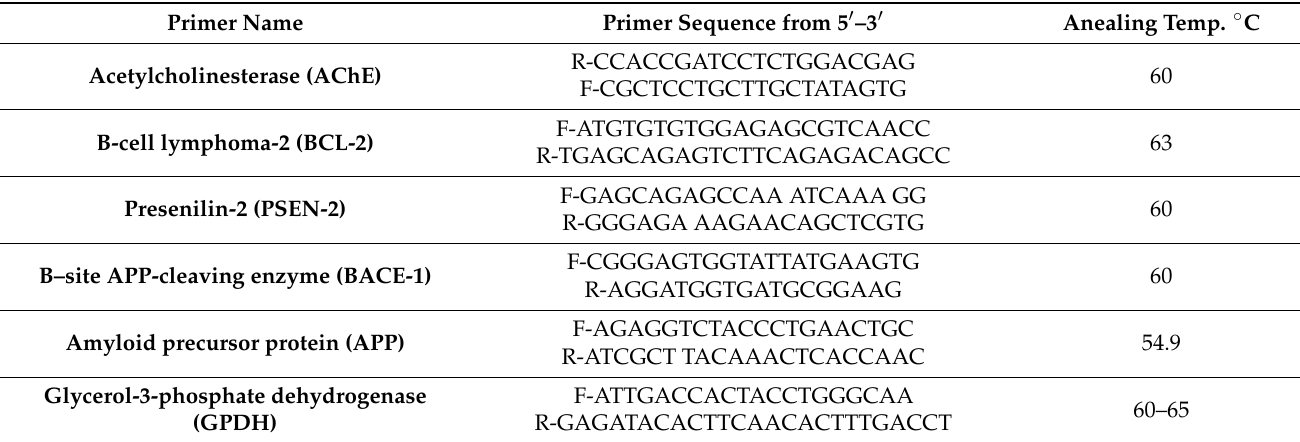
Table 6. Primers nucleotides sequence used in this